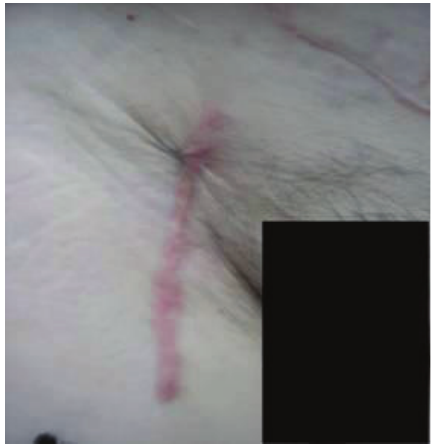
Figure 7: Healed wound during